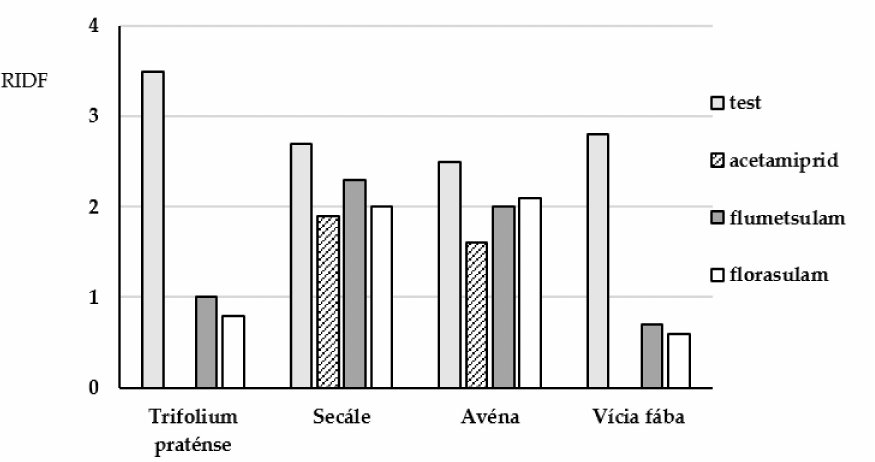
Figure 9. Dependence of the dynamics of changes in the relative index of delayed fluorescence (RIDF) on the pesticide